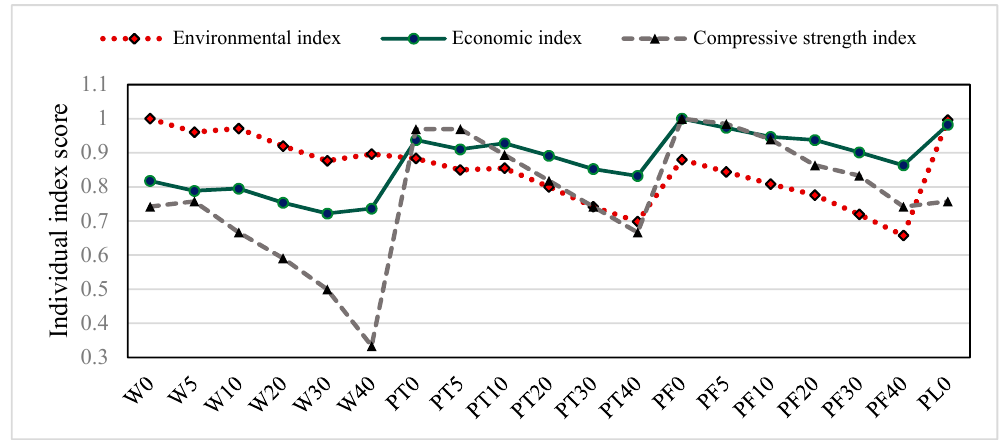
Figure 18. Environmental, economic and mechanical indexes for all mixes.